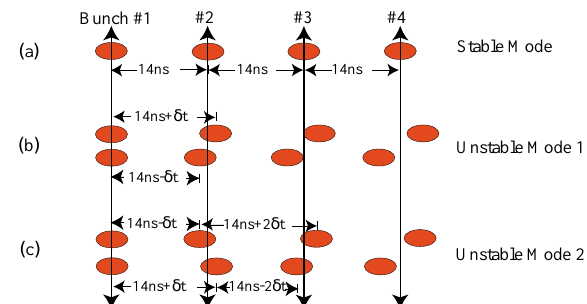
FIG. 4. (Color) A description of the dipole modes of oscillation is made with this diagram. If the bunches are stable and arrive at 14 ns intervals they are depicted in (a). Two possible unstable modes of oscillation are depicted in (b) and